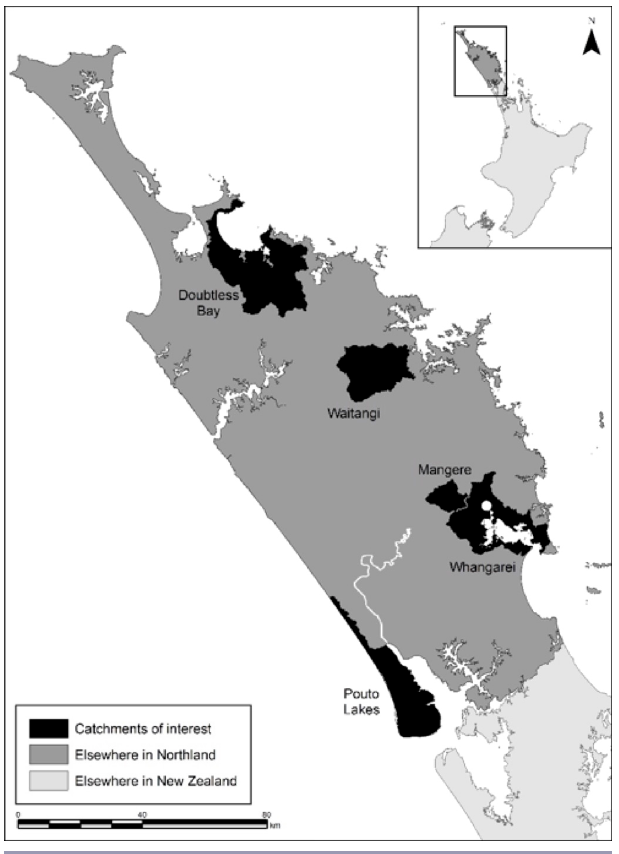
Fig. 4 . Waikato. The Waikato and Waipa catchments are